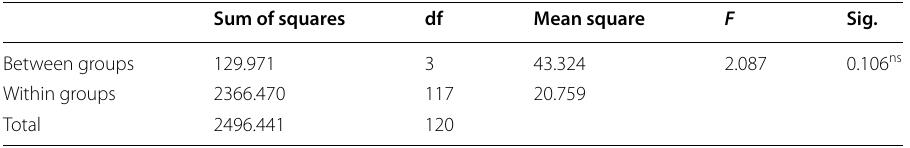
ns non‑significance level is 0.05